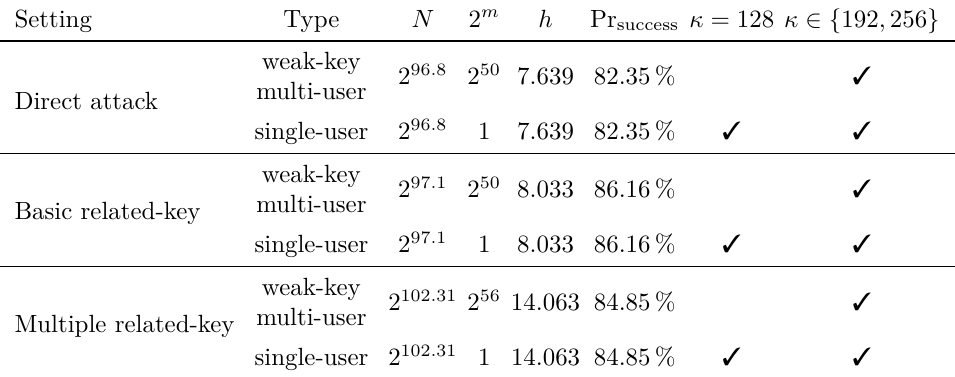
Table 5: Cryptanalysis results on the full TinyJAMBU v1.